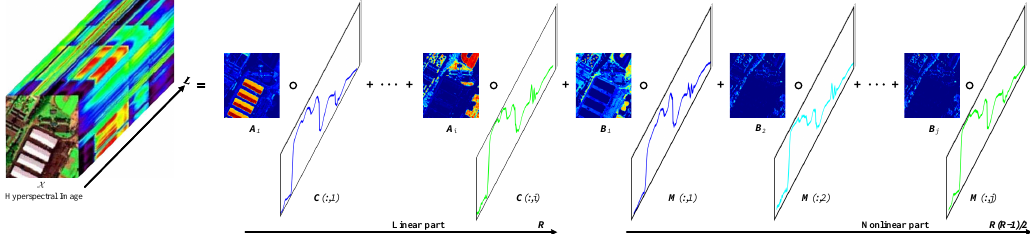
Figure 2. The representation of the generalized bilinear model using the tensor-based